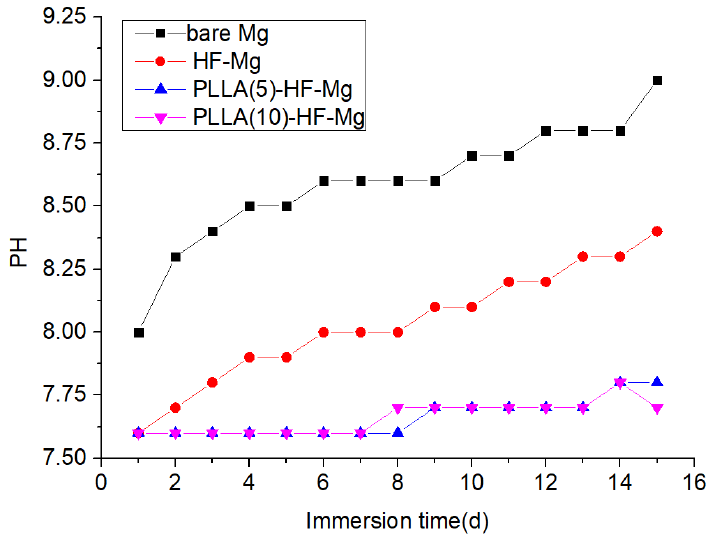
Figure 8. pH values of SBF solution for coated and bare Mg alloy over time after immersion.